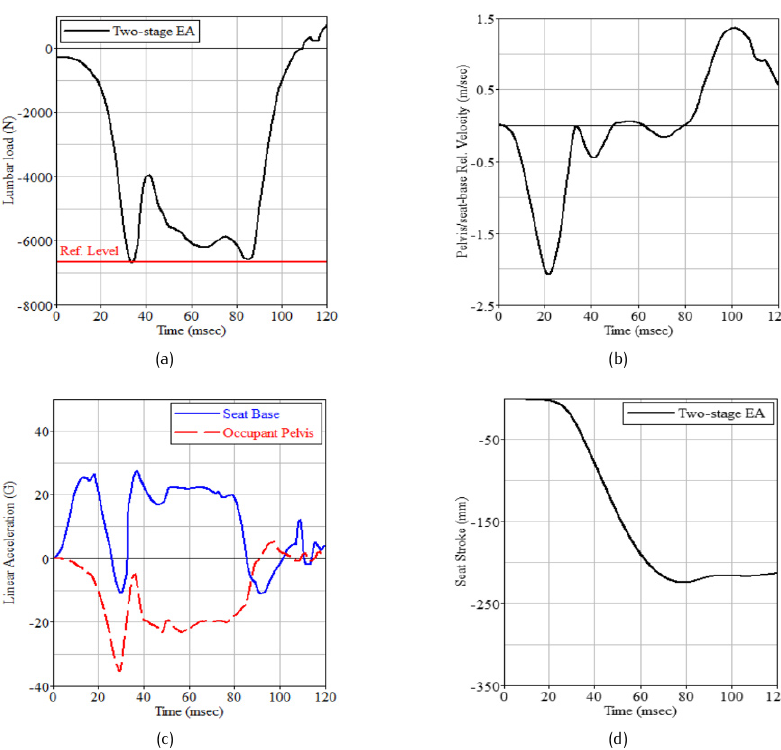
Figure 14. Occupant lumbar load, seat-base acceleration, seat/occupant relative velocity, and seat stroking curve for a two-stage load